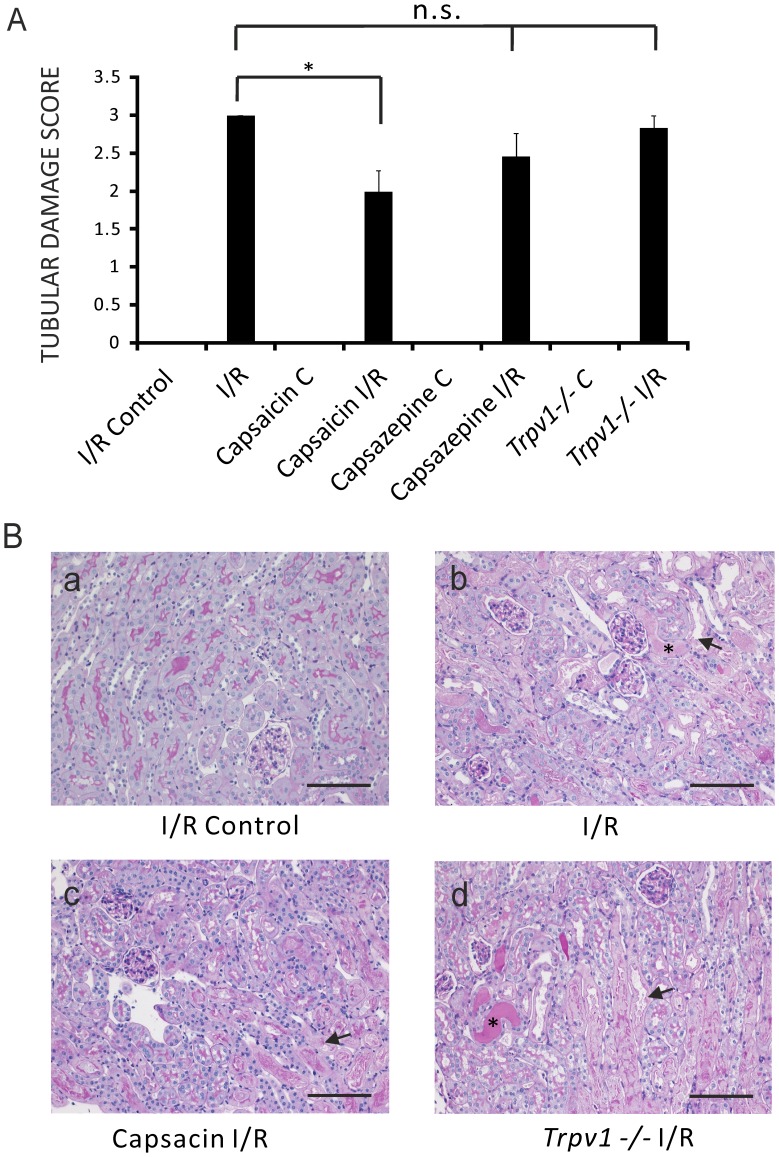
Amelioration of tubular damage score of I/R-induced AKI by pretreatment of mice with capsaicin, but not with capsazepine or genetic ablation of TRPV1.
Panel A: Tubular damage scores of ipsilateral kidneys (I/R Control) and kidneys after I/R (I/R) of control mice. Tubular damage scores of ipsilateral kidneys (Capsaicin C) and kidneys after I/R injury (Capsaicin I/R) of mice pretreated with capsaicin. Tubular damage scores of ipsilateral kidneys (Capsazepine C) and kidneys after I/R injury (Capsazepine I/R) of mice pretreated with capsazepine. Tubular damage scores of ipsilateral kidneys (Trpv1−/− C) and kidneys after I/R injury (Trpv1−/− I/R) of Trpv1−/− mice. Scores of ipsilateral control kidneys without I/R injury were all 0. *, P<0.05. P≥0.05; not significant. Panel B: Histological sections. (a) I/R Control, histology of ipsilateral kidney before renal I/R injury of a control mouse. (b) I/R, histology of kidney after I/R injury of a control mouse. The section shows acute tubular necrosis characterized by loss of tubular epithelial cells (arrow) and shedding of the brush border (asterisk). (c) Capsaicin I/R, histology of kidney after I/R injury of a mouse pretreated with capsaicin. Acute tubular necrosis (arrow). (d) Trpv1−/− I/R, histology of kidney after I/R injury of a Trpv1−/− mouse. Acute tubular necrosis (arrow) and shedding of the brush border (asterisk). Scale bar 100 µm. Magnification × 200.